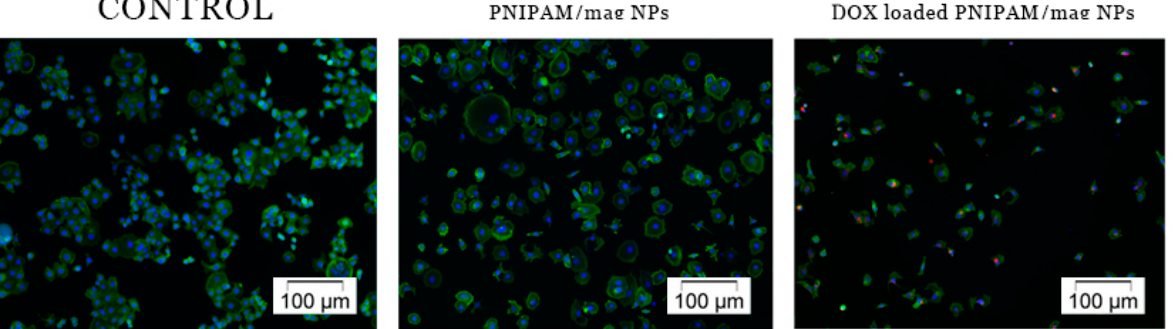
Figure 8. Fluorescence microscopy images of untreated MCF7 cells and MCF7 cells treated with pristine and DOX-loaded PNIPAM/magnetite NPs for 24 h and stained with phalloidin-FITC (green fluorescence—actin filaments) and DAPI (blue fluorescence—cells